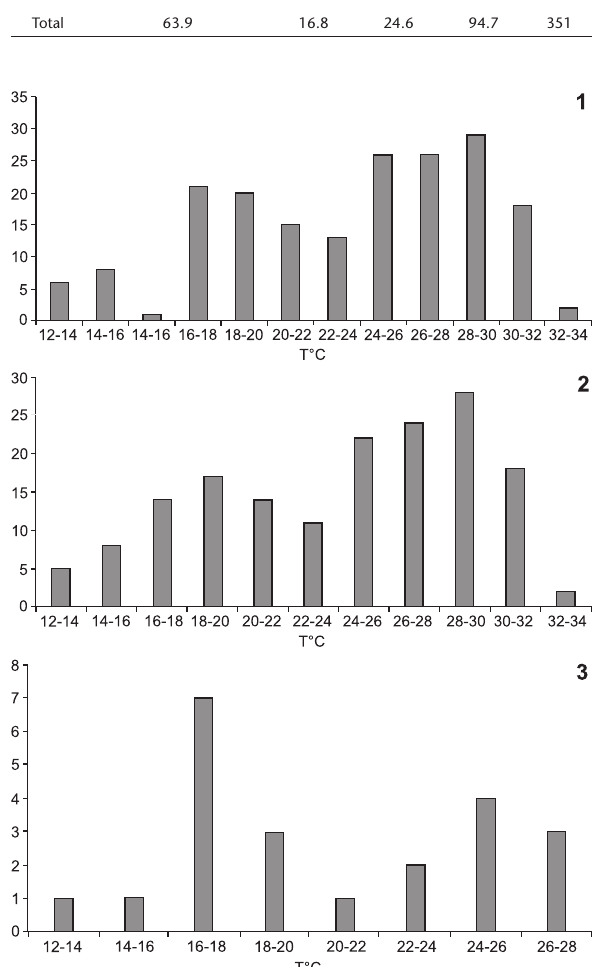
Figures 1–3. Frequency distribution of body temperatures of Am- phisbaena munoai found at São Jerônimo between March 2011 and October 2012 (n = 185). Body temperatures are shown for: (1)